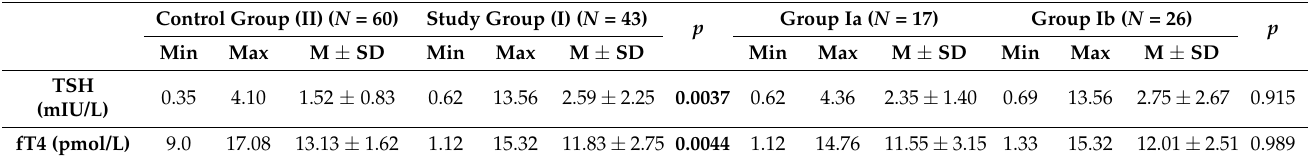
Table 2. The concentration of TSH and level of fT4 in the groups studied. Despite the significant differences, the values of TSH and free T4 were in normal range.